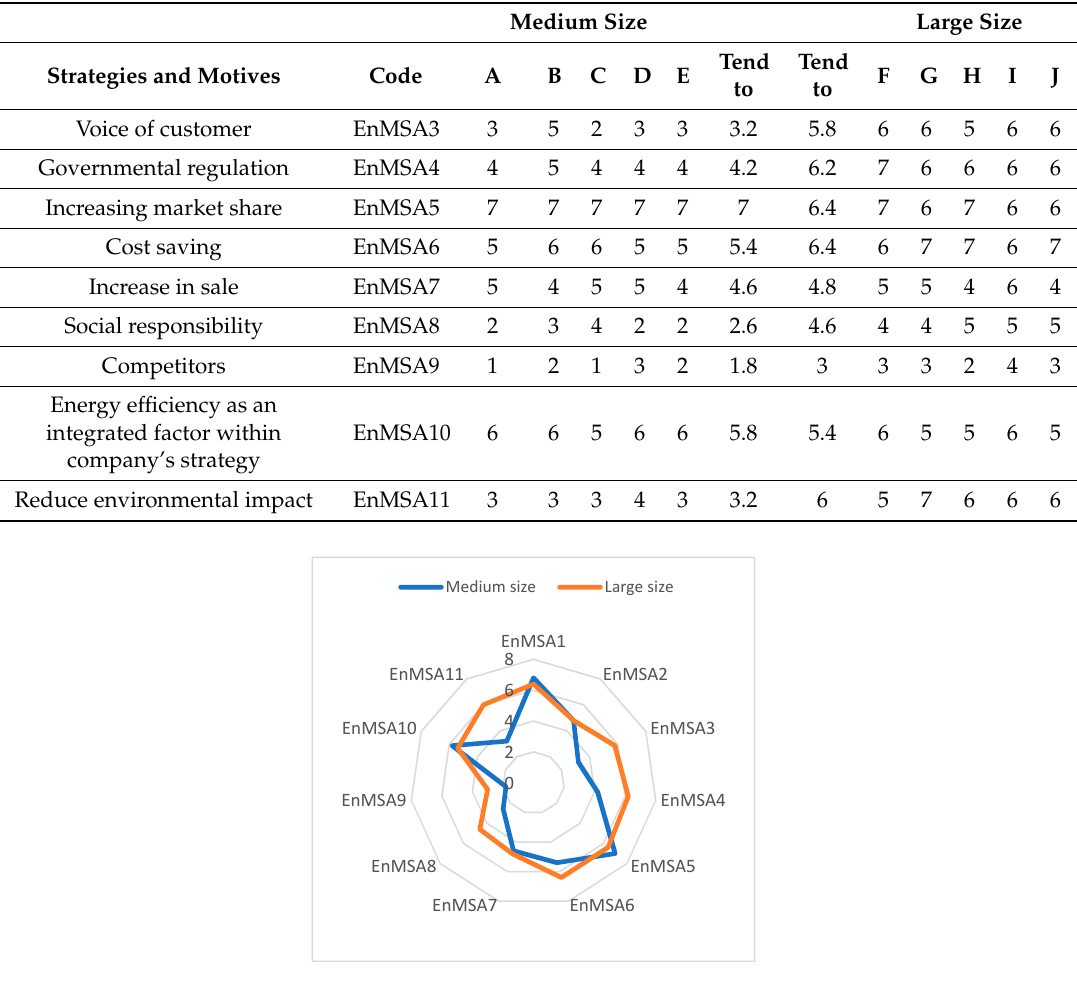
Figure 1. Comparing the results extracted from Table 1.